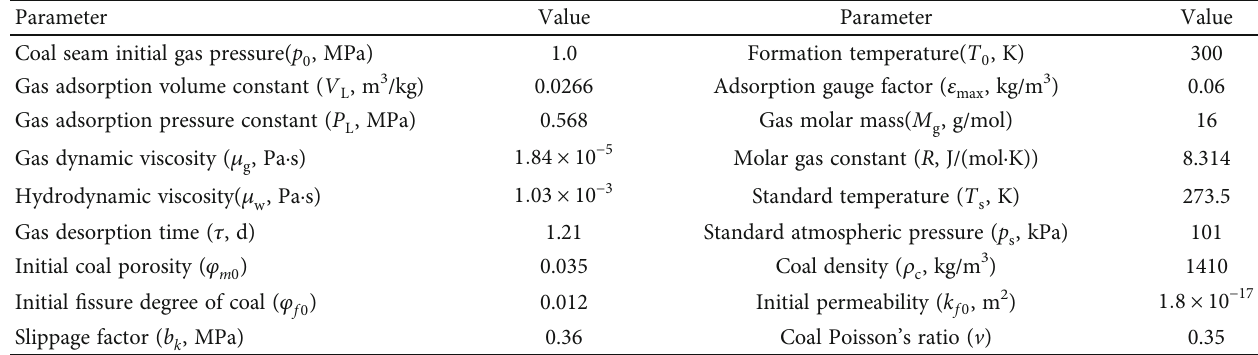
Table 1: Relevant parameters for numerical